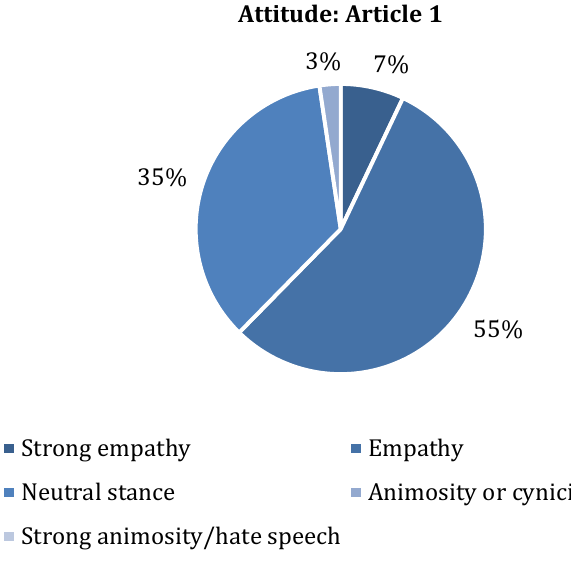
Figure 3: Attitude towards victim (when expressed) in Article 1